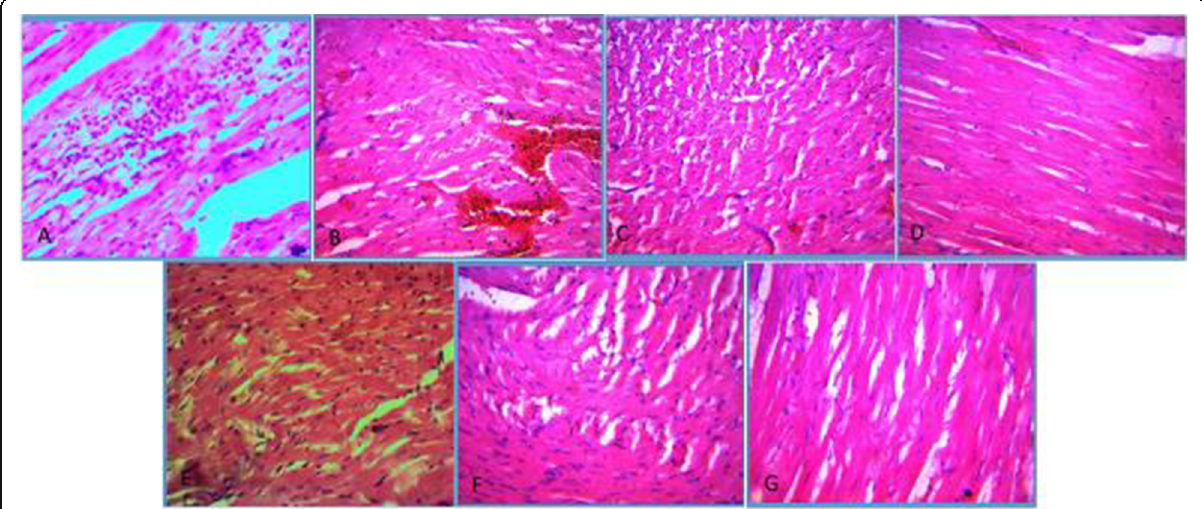
Fig. 4 Photomicrograph slides of rat heart (Hematoxylin and eosin staining, 100x magnification). A: Liver of Diabetic control; B: Liver of Obese diabetic control; C: Liver of Obese diabetic rats treated with 10% Pleurotus tuber-regium ; D: Liver of Obese diabetic rats treated with 20% Pleurotus tuber-regium ; E: Liver of Drug control rats; F: Liver of Obese control rats; G Liver of Normal control